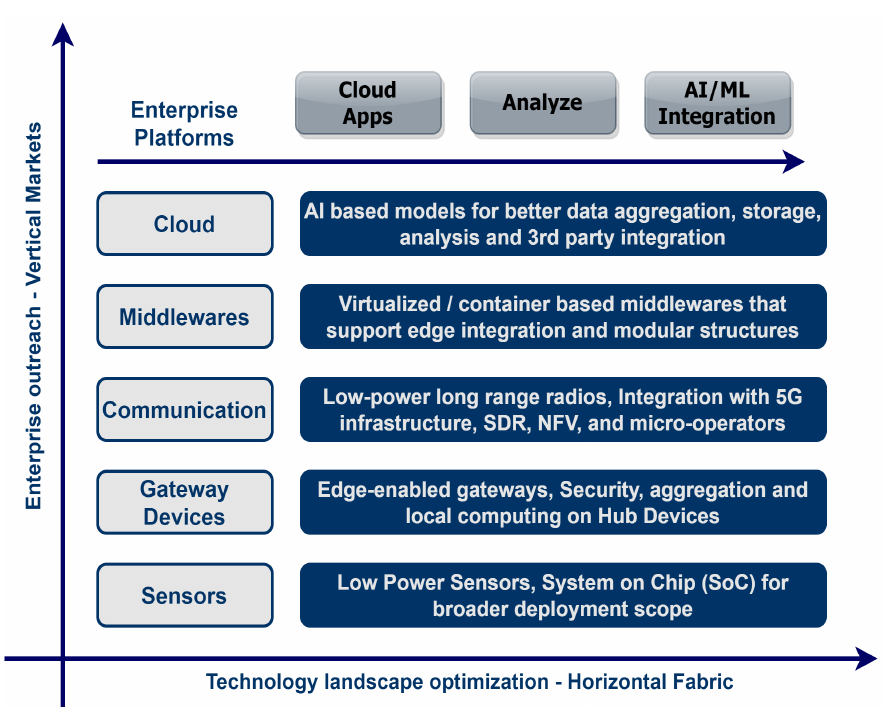
Figure 10. Proposed approaches for optimizing the entire IoT technology